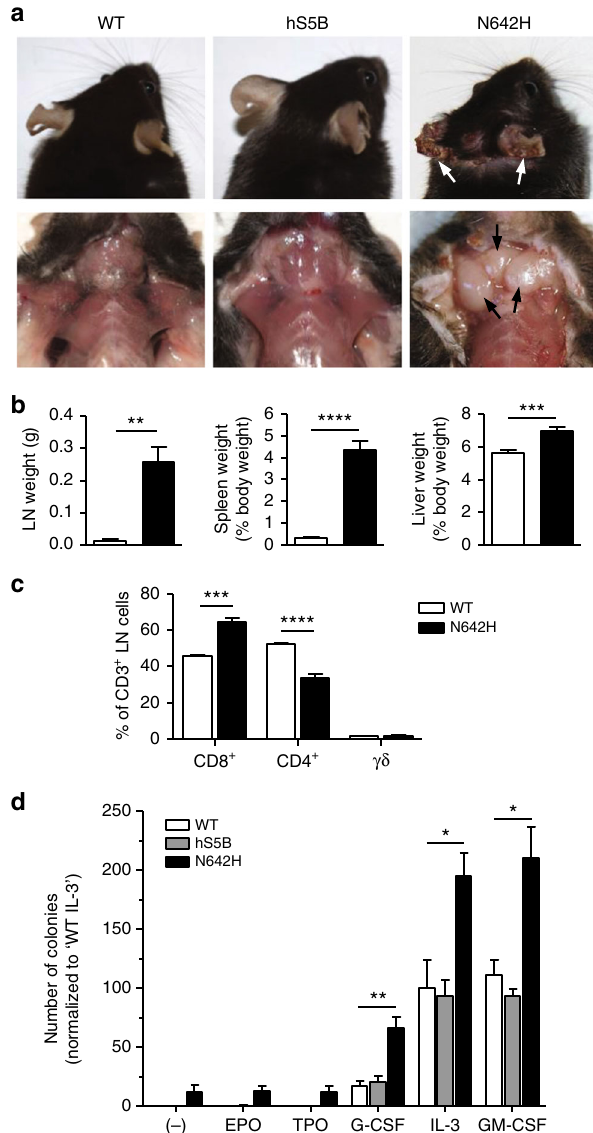
Fig. 2 STAT5B N642H promotes aggressive T-cell neoplasia and cytokine- independent cell growth. a Macroscopic images showing substantial skin lesions (upper panel; arrows) and lymphadenopathy (lower panels; arrows) observed in the STAT5B N642H transgenic mice, compared with human STAT5B and wild-type (WT) control mice. b Axillary, brachial and inguinal LN, spleen, and liver weights were measured from 7- to 9- week-old WT ( n = 4 – 6) and STAT5B N642H ( n = 5 – 8) transgenic mice. c Flow cytometric analysis of the percentage of CD8 + , CD4 + , or TCR γδ + T-cells from the CD3 + cell population in the LNs of 7-week-old WT ( n = 4) and STAT5B N642H ( n = 7) mice. d Colony-forming unit (CFU) assays using bone marrow cells from 7- to 10-week-old WT ( n = 4), human STAT5B ( n = 4) and human STAT5B N642H ( n = 5) mice, plated in duplicate in base methylcellulose in the presence (20 ng mL – 1 ) or absence (-) of individual cytokines. Colonies were counted after 10 days. All data are graphed as mean ± SEM. * p < 0.05, ** p < 0.01, *** p < 0.001, ANOVA with Bonferroni ’ s correction ( d ). Source data are provided as